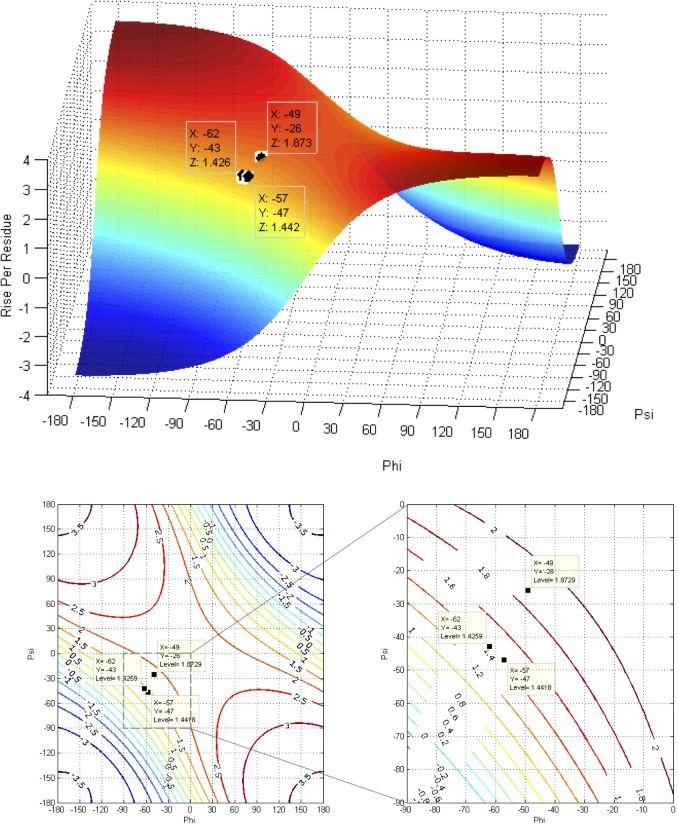
Contours and 3D surface showing rise-per-residue (d in Å) overlaid on 2D φ,ψ plot.Positions of classic α-helix (φ = −57, ψ = −47), 310-helix (φ = −49, ψ = −26), and Némethy-, N- or 3.613/10-helix (φ = −62, ψ = −43) are indicated. Note that d is approximately the same for the α- and 3.613/10-helices.